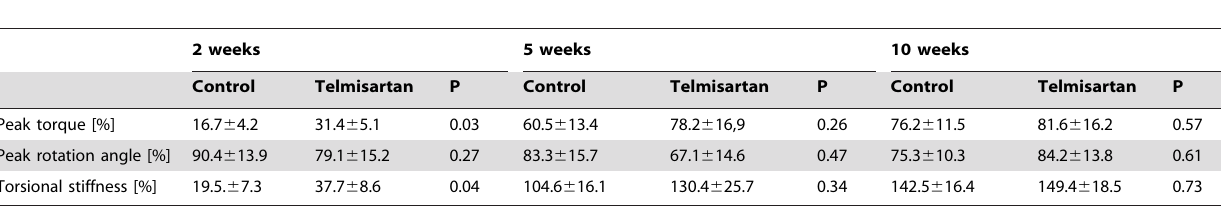
Table 1. Biomechanical analysis of the callus of telmisartan-treated and vehicle-treated animals at 2, 5 and 10 weeks after fracture